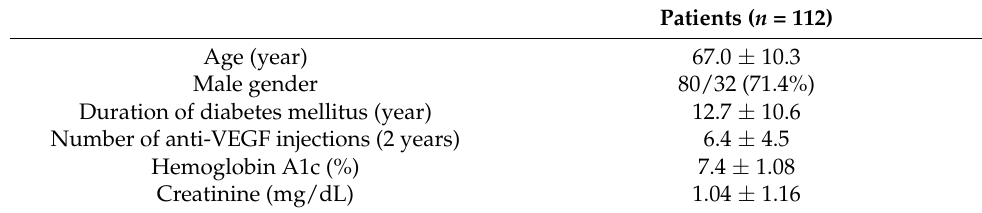
Table 1. Baseline characteristics of enrolled